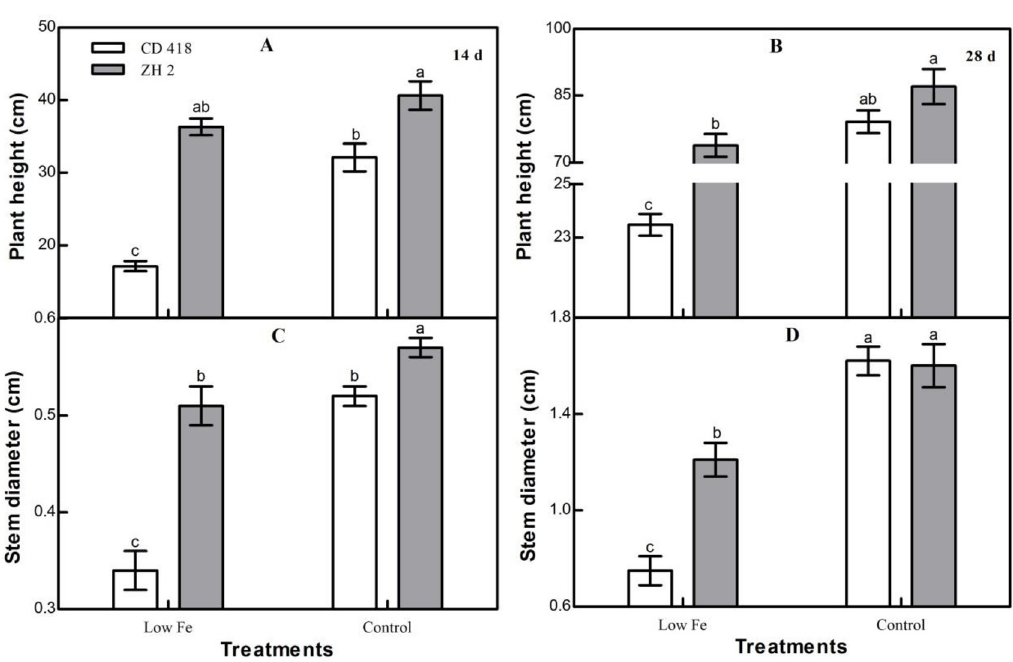
Fig 2. Plant heights and stem diameters of two maize cultivars grown under different Fe concentrations for 14 or 28 d. Data are the mean ± SE of three replicate pots. Values with different lowercase letters are significantly different at p < 0.05. https://doi.org/10.1371/journal.pone.0239075.g002 diameter of the Fe-efficient cultivar ZH 2 were notably lesser than those of the Fe-inefficient cultivar CD 418. The differences in plant height and stem diameters between ZH 2 and CD 418 increased with longer stress times. The decreases in plant height and stem diameter of CD 418 were greater than those of ZH 2 by 30.06% and 24.09%, respectively, 14 days after treat- ment, and 55.12% and 28.32%, respectively, 28 days after treatment. Under low Fe stress, the shoot, root, and total dry weight of maize seedlings decreased sig- nificantly, while the root to shoot ratio increased markedly and the variation increased at the longer stress time (Table 1). At 14 d after treatment, the shoot dry weight of ZH 2 and CD 418